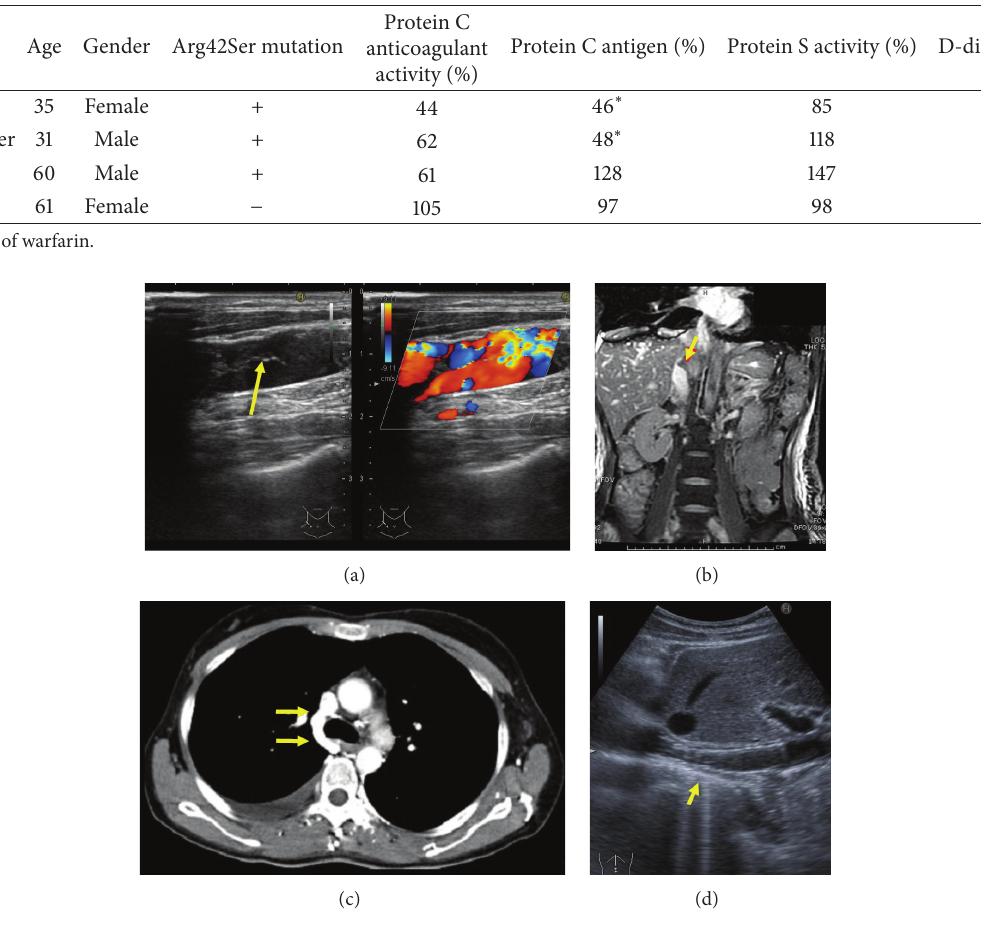
Table 2: Analysis of clotting factors.